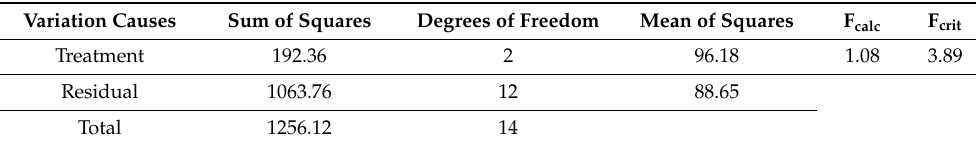
Table 10. ANOVA of the BFS depth from the ballistic tests of MAS with arapaima scales composites as second